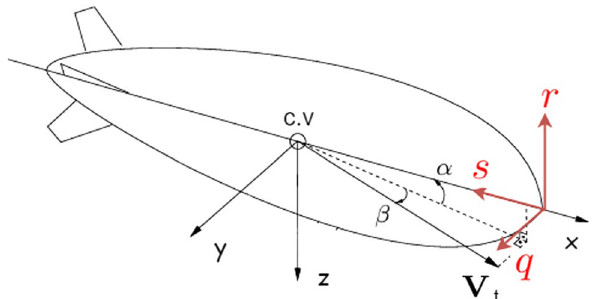
Fig. 3 Airship aerodynamic